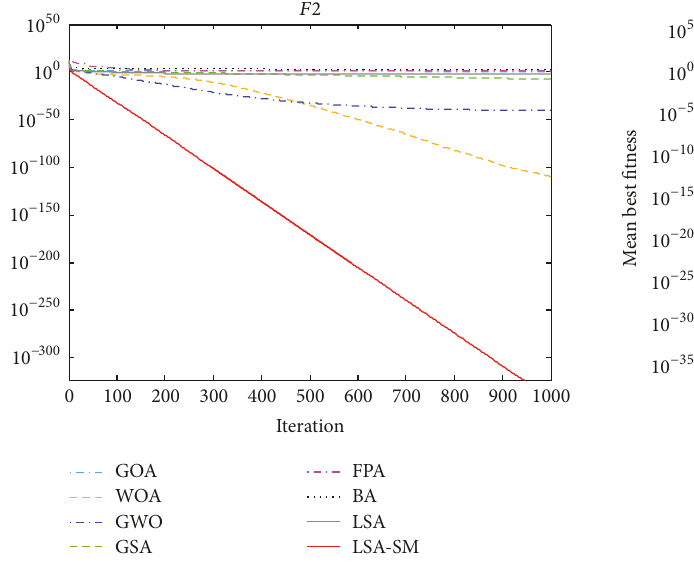
Figure 6: 𝐷 = 30 , convergence curves for 𝑓 02 .